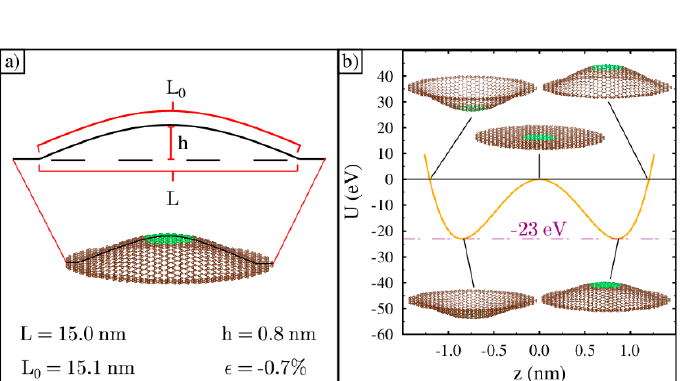
Figure 2. Ripple construction and the double-well potential: ( a ) An example graphene ripple constructed after compressing a flat sheet by 0.7% and adding a third dimension so that the arc length equals its original uncompressed length; ( b ) The double-well potential for the ripple. Five ripple illustrations show the shape at different points along the energy curve. The function precisely fits the five energy data points found at zero Kelvin by stretching and compressing the lattice by 0.7%.